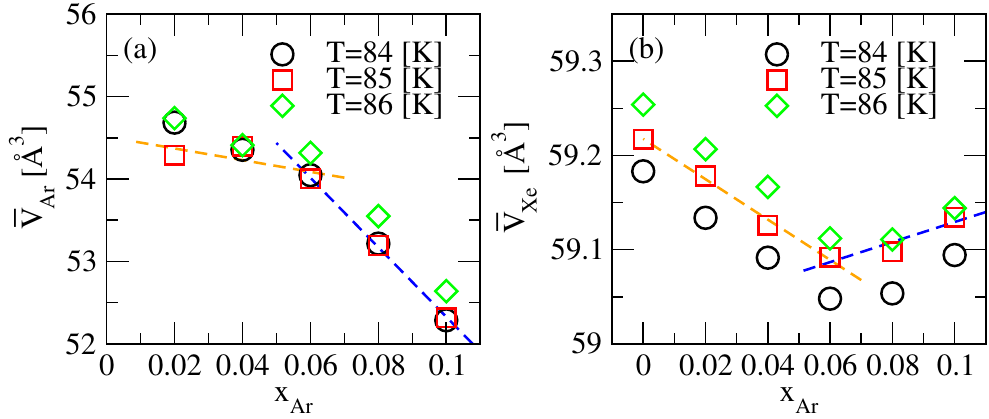
Figure 6. Partial molar volumes from KBIs as a function of Ar concentration x Ar for different temperatures. ¯ V Ar in ( a ) and ¯ V Xe in ( b ). Broken lines are linear fits in the x Ar range 0.00–0.06 (orange) and 0.06–0.10 (blue).